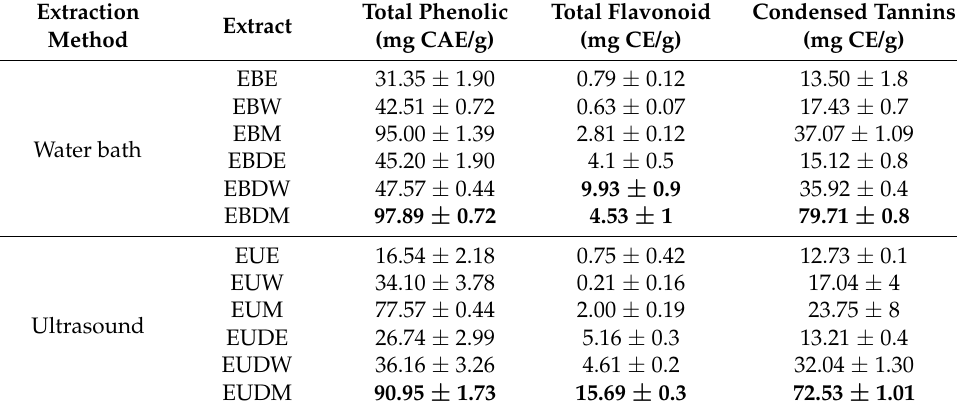
Table 2. Total phenolic content, total flavonoids, and condensed tannins extracted from coffee husk.